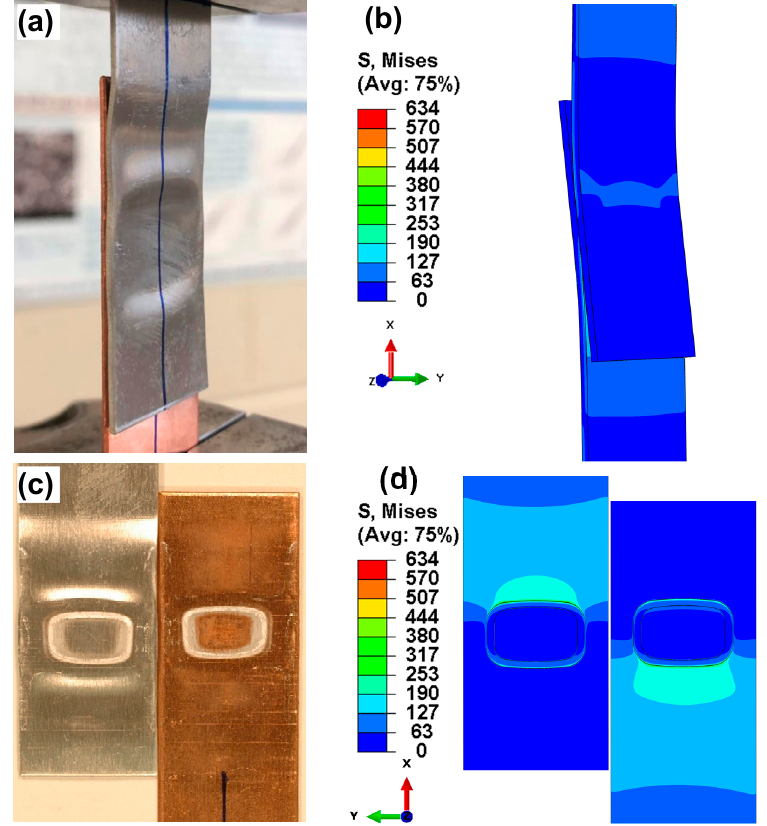
Figure 6. Typical fatigue sample of Al/Cu dissimilar lap joint and FEA simulation results. ( a ) Fatigue test of Al/Cu sample; ( b ) FEA result of (a); ( c ) morphology of fracture surface of Al/Cu sample, and ( d ) FEA result of (c).